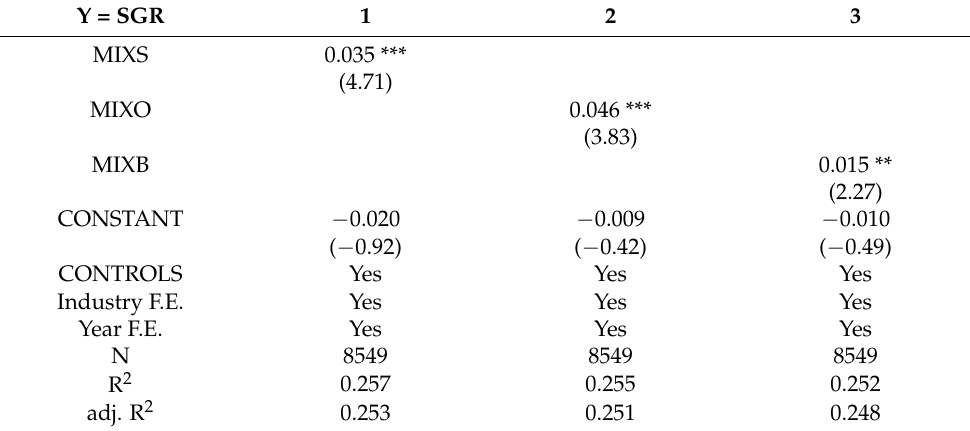
Table 13. The impact of mixed-ownership reform on the sustainable development of SOEs. Y =